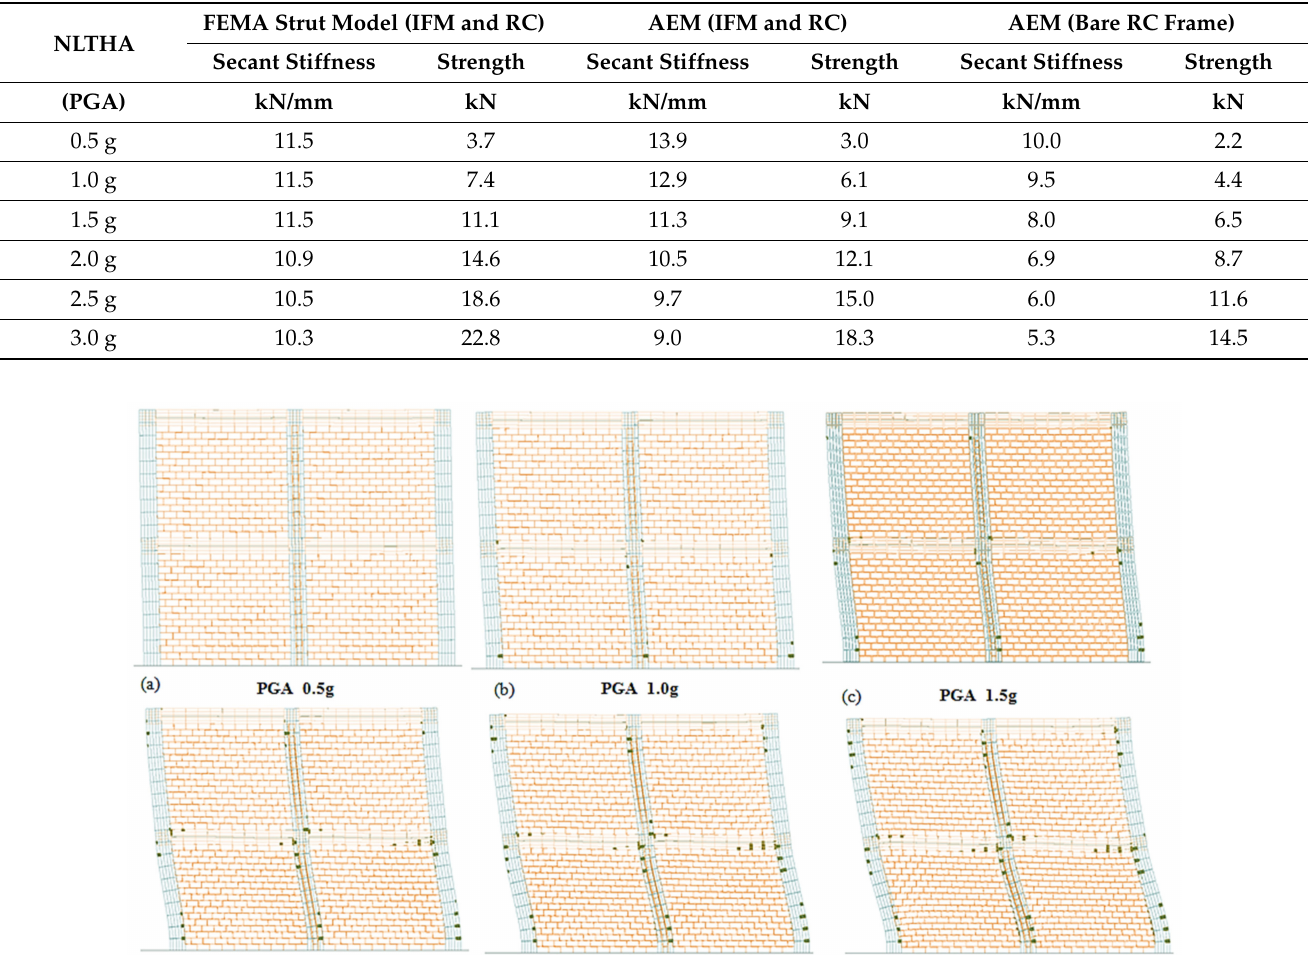
Figure 21. Comparison of pushover curve and dynamic analysis results of AEM models for H- building structure (RC and IFM). Table 5. Reported results of Dynamic Analysis for scaled H-Building Structure.